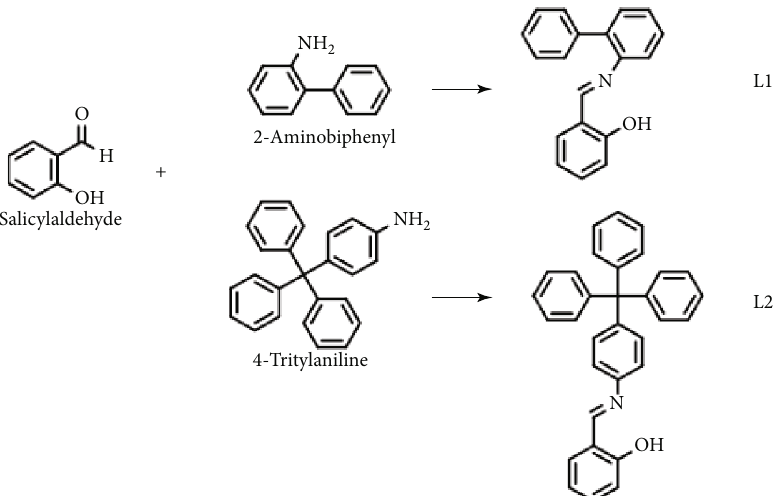
Scheme 1: Synthetic procedure for ligands L1 and